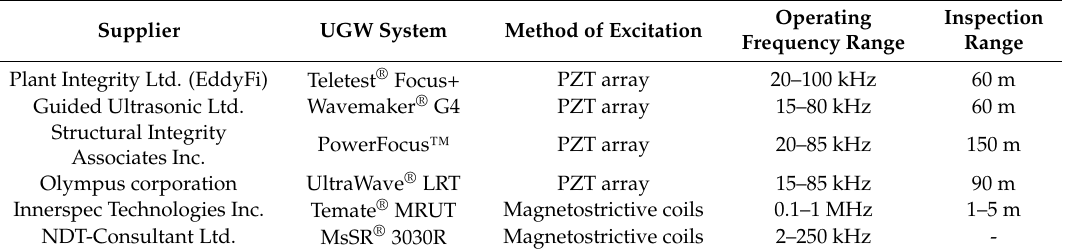
Table 1. Comparison of Ultrasonic Guided Wave systems on the commercial